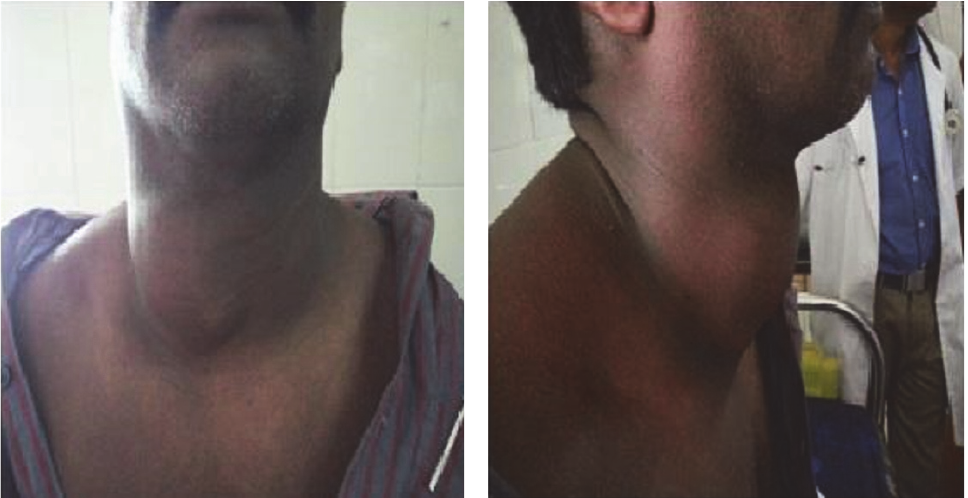
Figure 1: Profile of the patient showing the swelling from front and side.